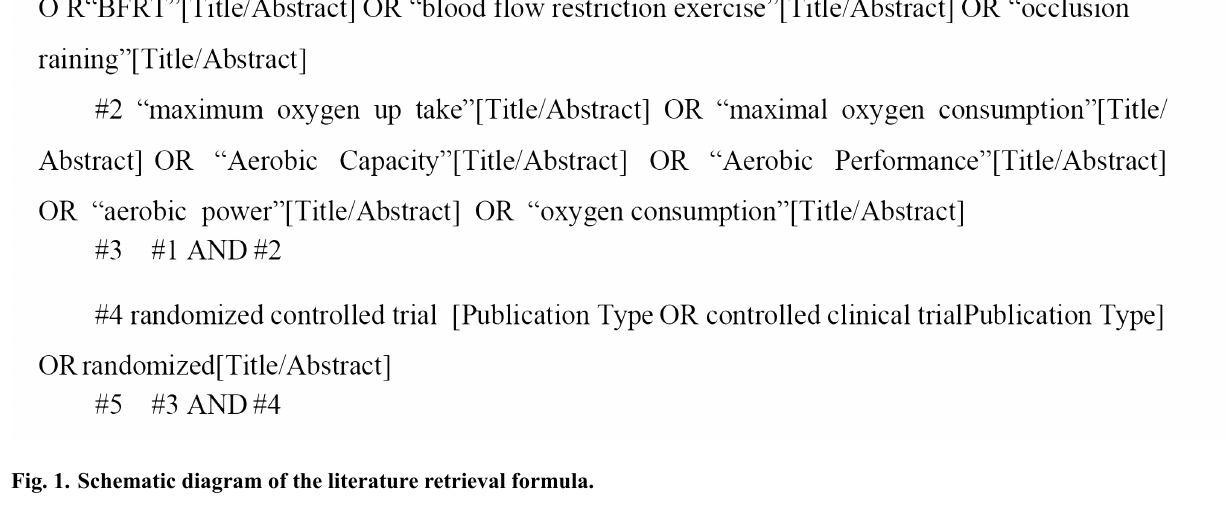
Fig. 1. Schematic diagram of the literature retrieval